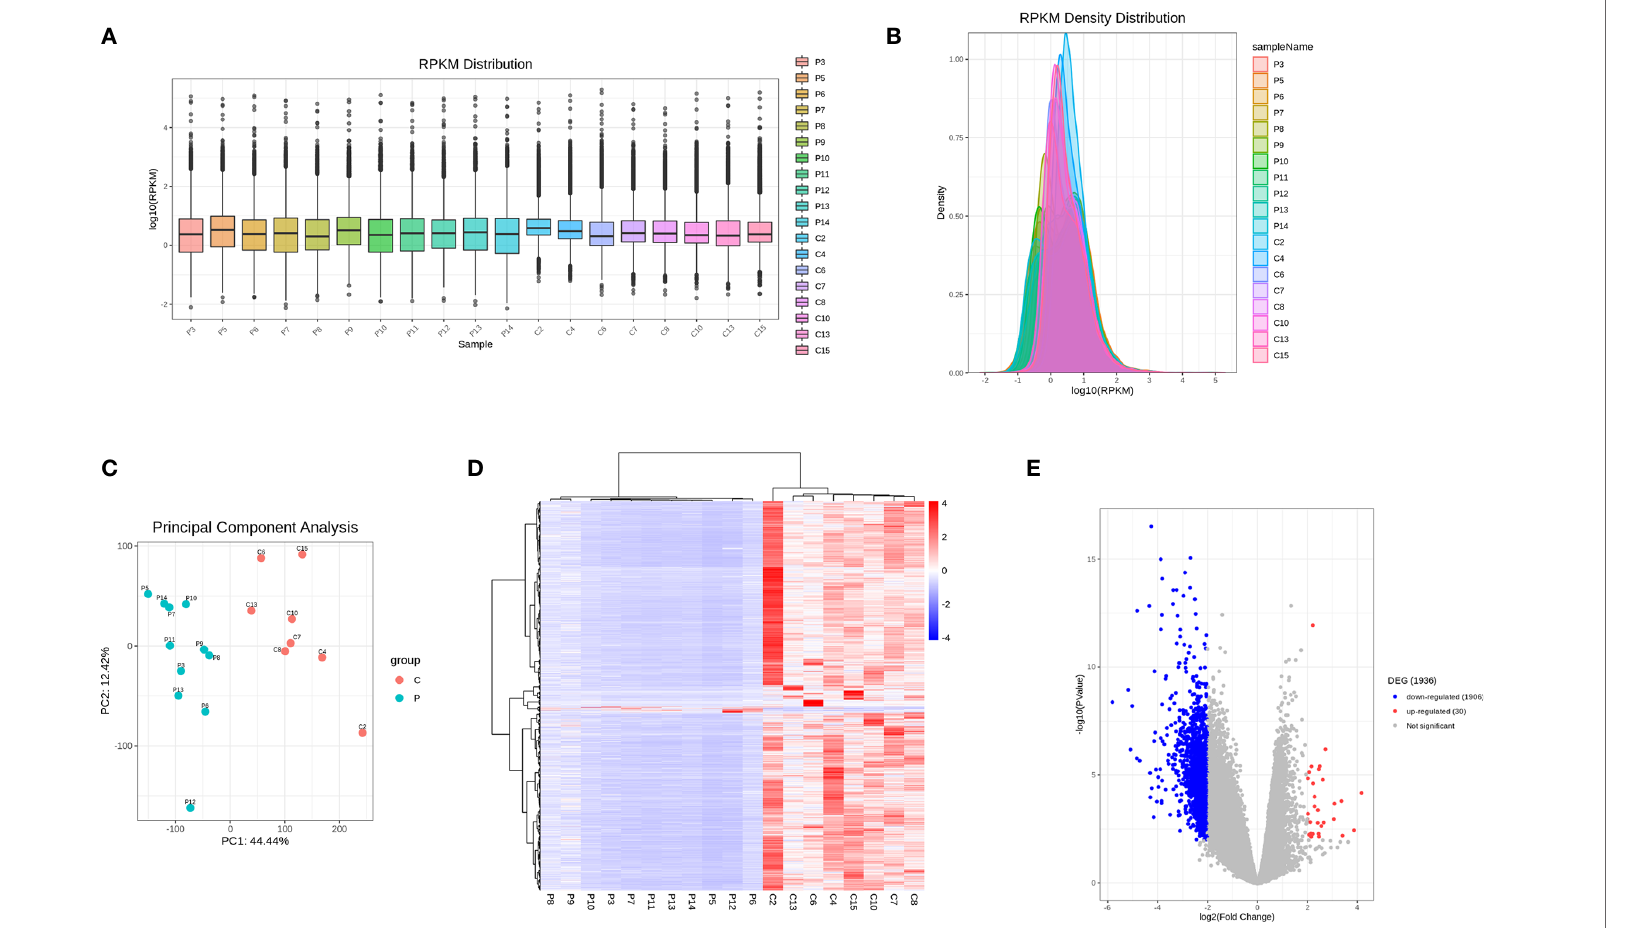
FIGURE 1 | RNA-seq analysis of differentially expressed genes between PCOS and control group. (A) Boxplots of abundance of transcripts in each sample. (B) RPKM density distribution in each sample. (C) PCA of averaged, rank-normalized read counts from RNA-seq. (D) Heatmap analysis of differentially expressed genes between control group and PCOS group. (E) Volcano plots showing the signi fi cance and log2 fold- change (logFC) for all gene transcripts reliably detected in the RNA-seq analysis between control group and PCOS